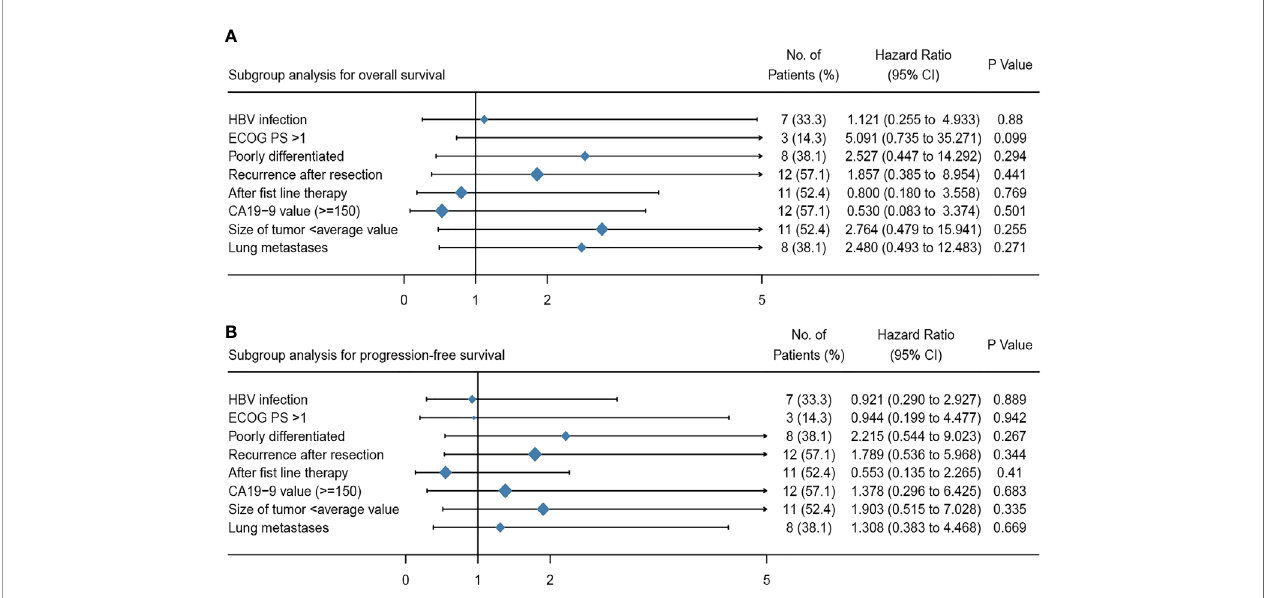
FIGURE 5 | Multivariate analyses of the overall survival (A) and progression free survival (B) for patients treated with apatinib plus camrelizumab. ECOG PS, Eastern Cooperative Oncology Group performance status; CA19-9, carbohydrate antigen